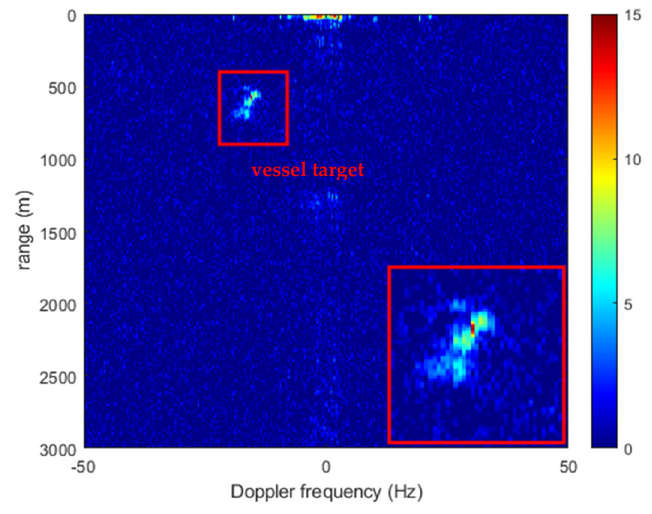
Figure 12. Final RD map for the maritime experiment.